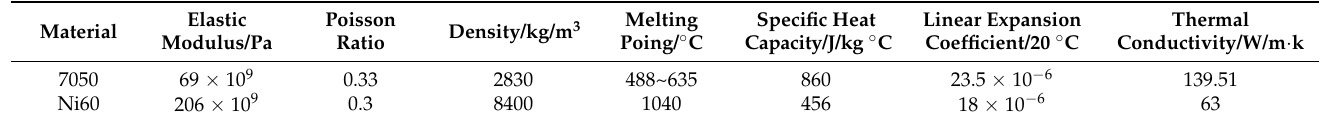
Table 1. Thermophysical parameters of 7050 aluminum alloy and